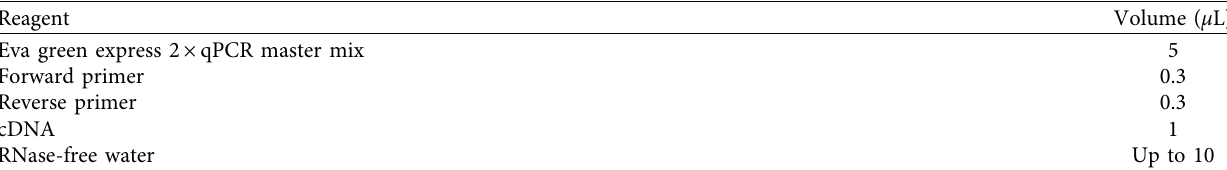
Table 2: Fluorescence quantitative PCR system.